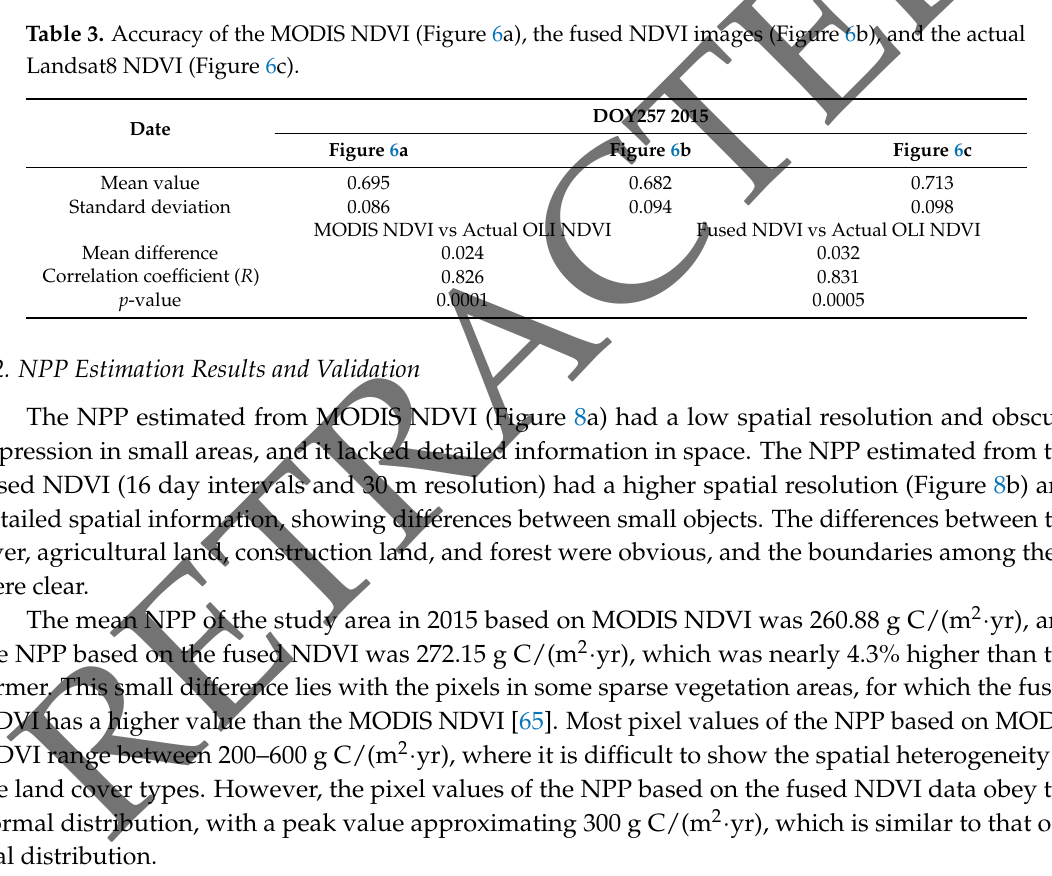
Figure 8. NPP estimations based on ( a ) MODIS NDVI data and ( b ) the fused NDVI data. The mean NPP of the study area in 2015 based on MODIS NDVI was 260.88 g C/ ( m 2 ∙ yr ) , and the NPP based on the fused NDVI was 272.15 g C/(m 2 ∙ yr), which was nearly 4.3% higher than the